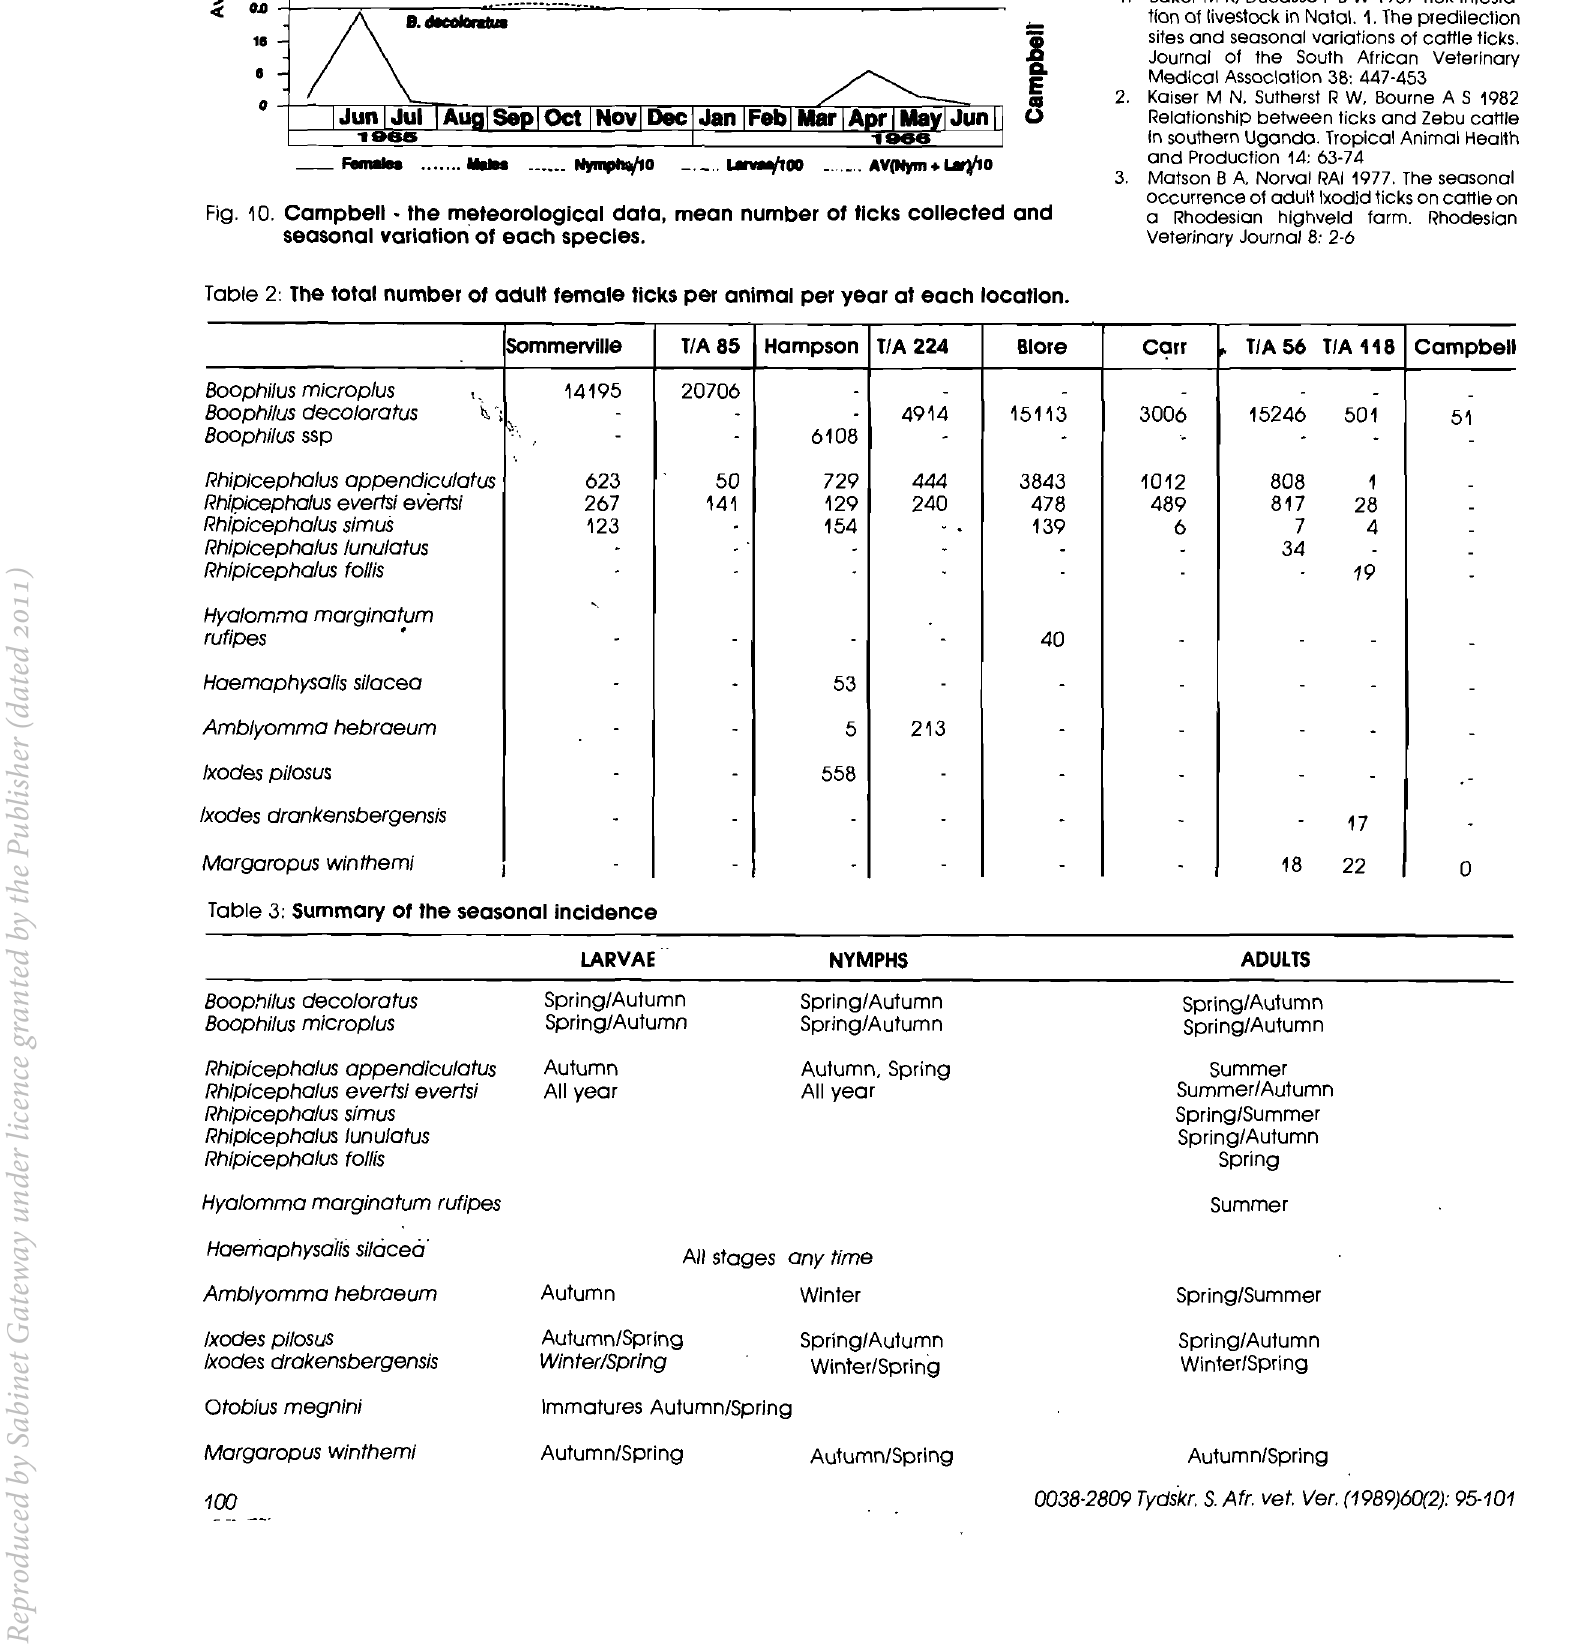
Fig. 10. Campbell· the meteorological data, mean number of ticks collected and seasonal variation of each species. Table 2: The total number of adult female ticks per animal per year at each location. Sommerville